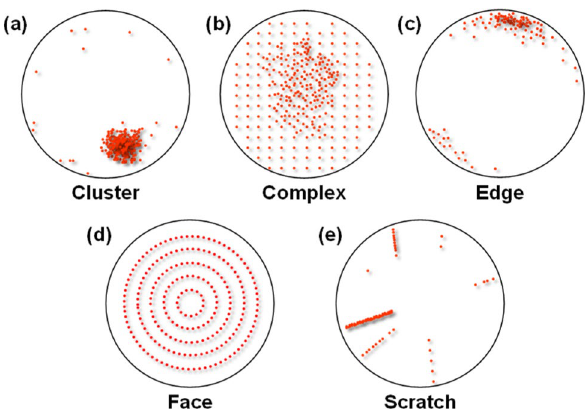
Figure 2. Typical examples of 5 wafer surface defect classes: ( a ) Cluster, ( b ) Complex, ( c ) Edge, ( d ) Face, and ( e )